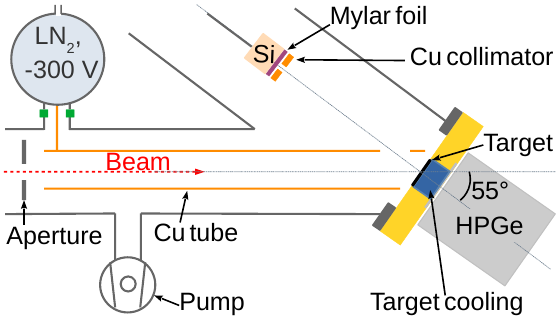
Figure 1. Sketch of the experimental setup used for the measurement of the 6 Li(p, γ ) 7 Be cross section at LUNA